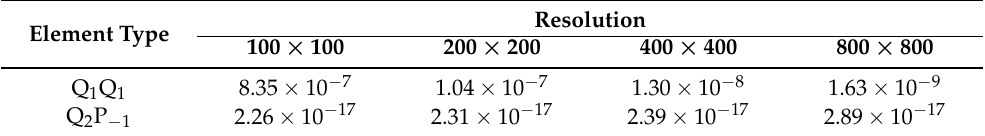
normalized by the number of elements. 2